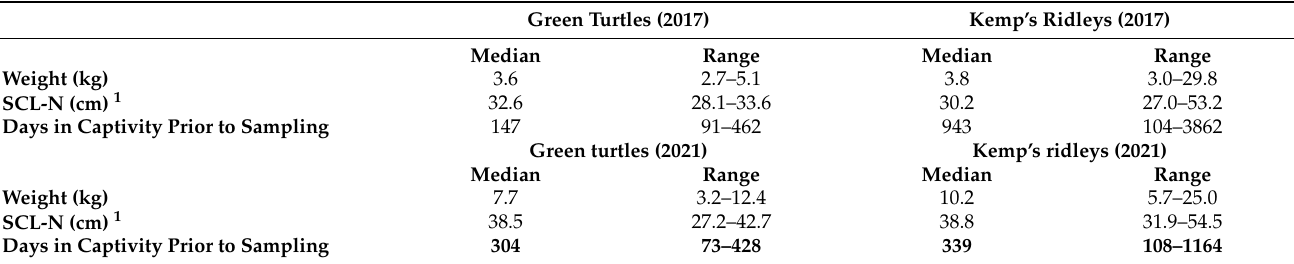
Table 1. Size data for green (2017; n = 7; 2021; n = 7) and Kemp’s ridley (2017; n = 5; 2021; n = 5) turtles investigated for analysis of circulating fatty acid profile precentages in managed care with a comparison between whole blood cards analyzed immediately and stored ( − 80 ◦ C) for 4